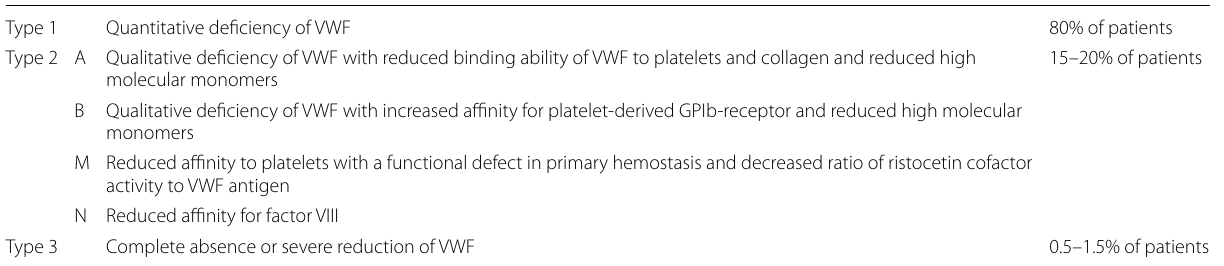
Table 1 Different types of von Willebrand disease (VWD)